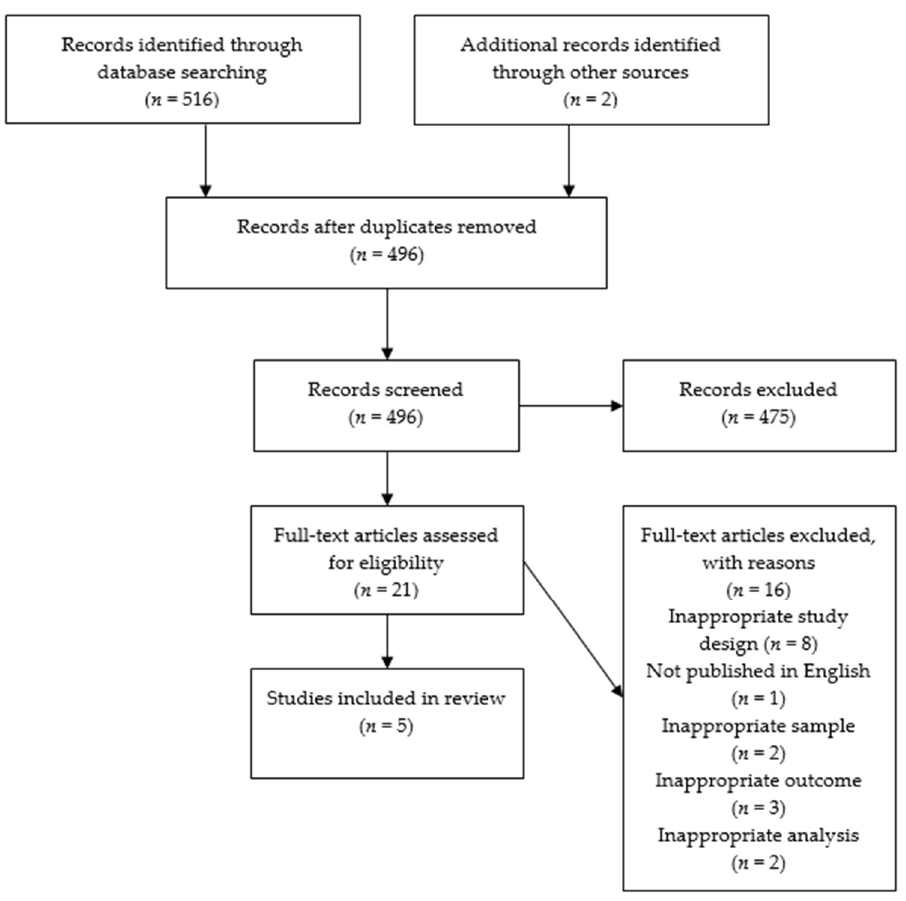
Figure 1. PRISMA diagram of search results.